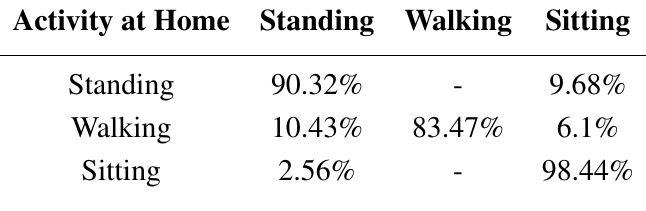
Table 2. Activity Recognition Accuracy for